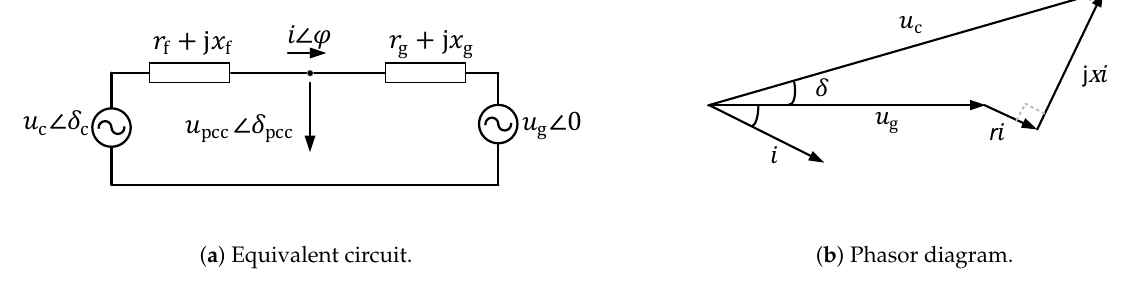
Figure 10. Power control of a grid-forming converter connected to a